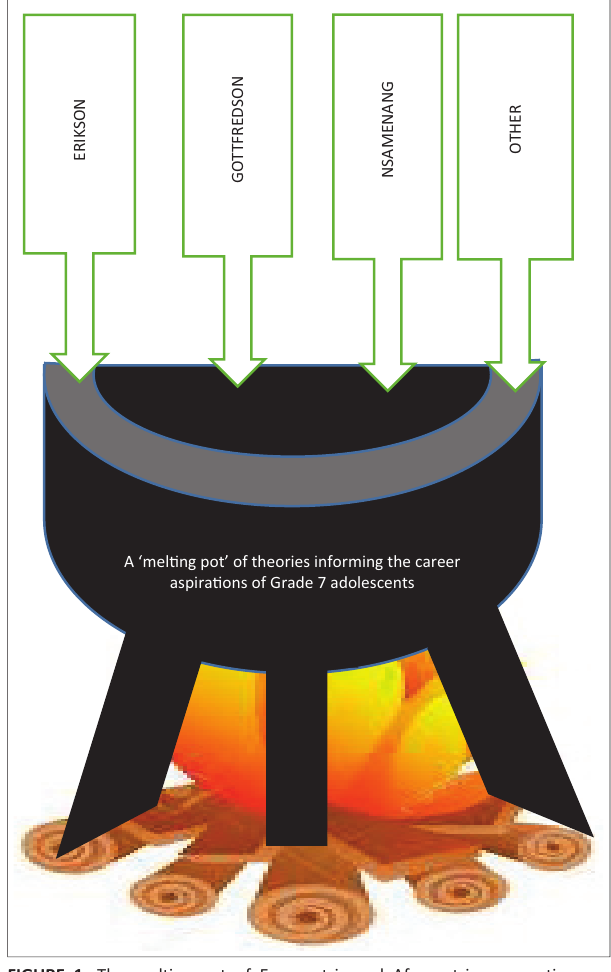
FIGURE 1: The melting pot of Eurocentric and Afrocentric perspectives on adolescents and their career